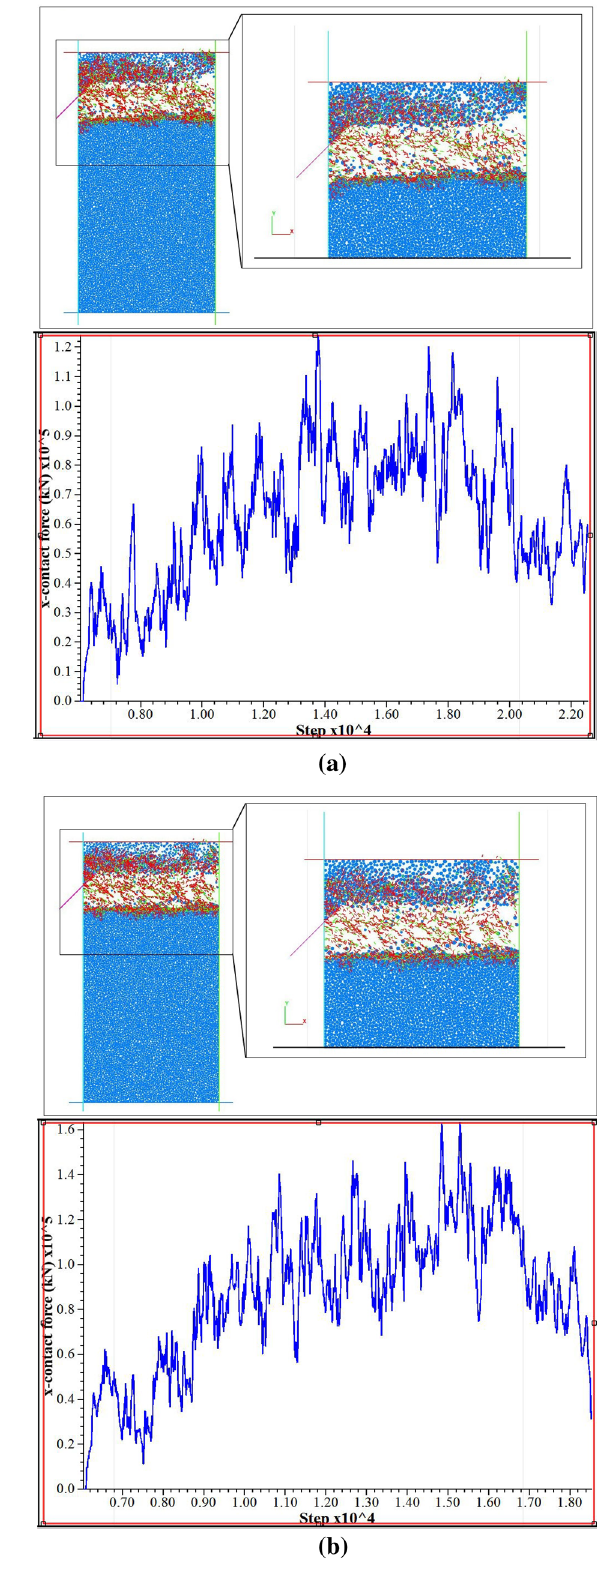
Fig. 13 Results of plow model with zero-degree angle: a Model 13, b Model 14